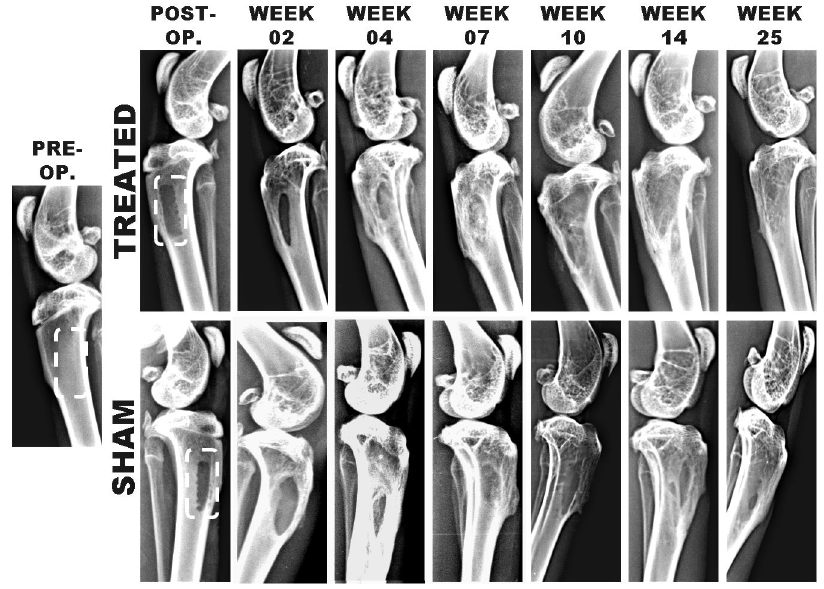
Figure 3. Radiograph of entire length of each tibia, taken pre-operatively (extreme left), immediately after creating defect, and after weeks 02, 04, 07, 10, 14 and 25 of n-HA/gel/CMC treated and SHAM-operated defects. It is worth noting that the radio-density at the n-HA/gel/CMC treated site was comparable to that of the host bone at week 14 and 25.